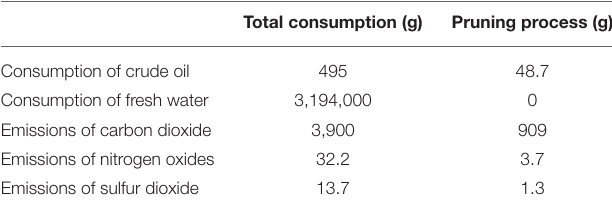
TABLE 1 | Overall consumption and emissions by production of 1l of olive oil (Avraamides and Fatta,